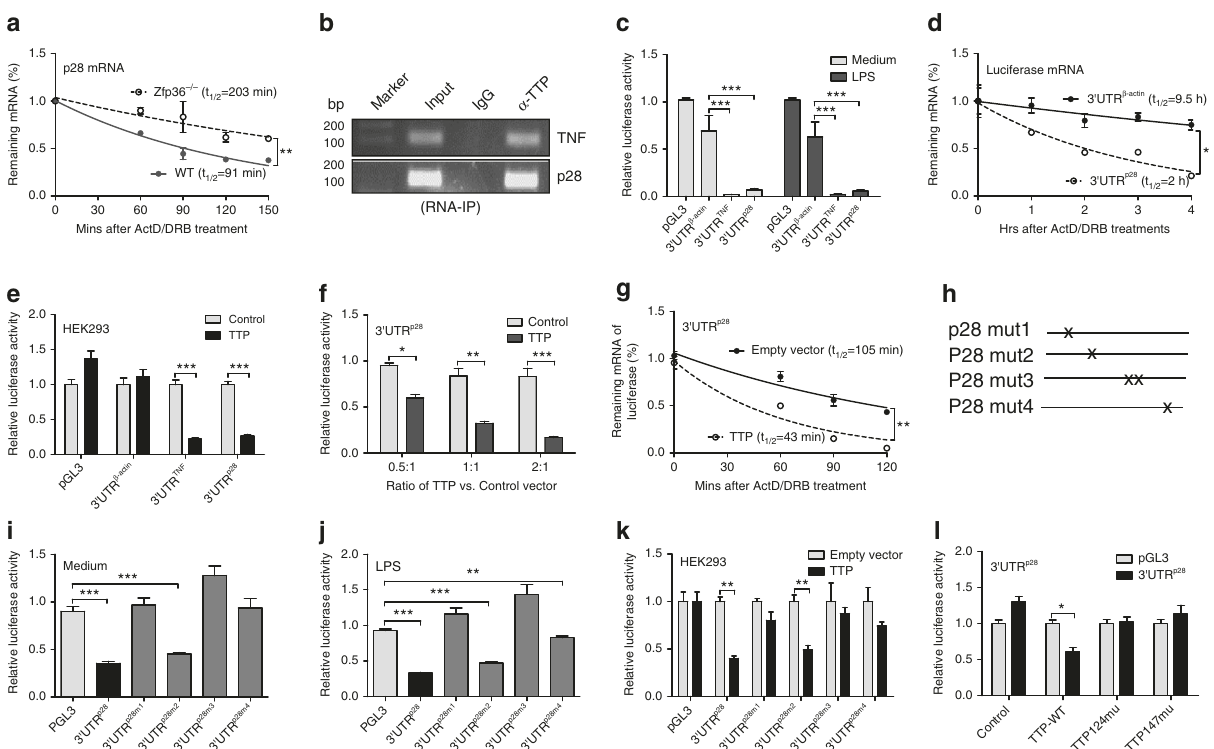
Fig. 4 TTP regulates IL-27 p28 mRNA stability through ARE sites in the 3 ′ UTR. a WT and Zfp36 − / − BMDMs were stimulated by LPS for 4 h. Then ActD (10 μ g/ml) and DBR (5 μ M) were added and RNA extracted at indicated time points. The remaining p28 mRNA levels were measured by qRT-PCR and normalized to the results at 0 min after ActD/DRB treatment ( t -test, n = 3). b Whole cell lysates extracted from J774 cells stimulated with LPS were used for RNA-IP with anti-TTP antibody. p28 and TNF mRNA were detected by RT-PCR in RNA extracted from the IPed complex. c Luciferase constructs carrying the 3 ′ UTRs of genes encoding β -actin (3 ′ UTR β -actin ), TNF (3 ′ UTR TNF ), p28 (3 ′ UTR p28 ) or empty vector (PGL3) was transfected into J774 cells by electroporation. Cells were treated with LPS for 7 h, and luciferase activities were measured and normalized to the activities obtained in PGL3-transfected cells without treatment (Medium) ( n = 3). d Luciferase mRNA half-life was measured by qRT-PCR in cells as in c after ActD/DRB treatment for different times ( t -test, n = 3). e , f p28 3 ′ UTR luciferase construct was co-transfected with different amounts of TTP expression plasmid into HEK293 cells. Luciferase activity was detected after 48 h and normalized to the cells transfected with empty plasmid (control) ( t -test, n = 3). g Luciferase mRNA half-life was measured in HEK293 cells transfected with TTP or control plasmids after ActD/DRB treatment for different times ( t -test, n = 3). h Schematics of ARE mutants in the p28 3 ′ UTR. i , j pGL3, p28 3 ′ UTR, and p28 3 ′ UTR mutant luciferase constructs were transfected into J774 cells by electroporation. Cells were treated by LPS for 24 h. Luciferase activities were measured and normalized to the activities in PGL3-transfected cells. k pGL3 and p28 3 ′ UTR luciferase constructs were co-transfected with TTP or control plasmids into HEK293 cells. Luciferase activity was detected at 48 h. l p28 3 ′ UTR or pGL3 luciferase constructs were co-transfected with WT and mutant TTP into HEK293 cells. Luciferase activity was measured after 48 h. One-way ANOVA with Tukey was used as in ( c , i – l ) with n = 3. * p < 0.05; ** p < 0.01; *** p < 0.001 between